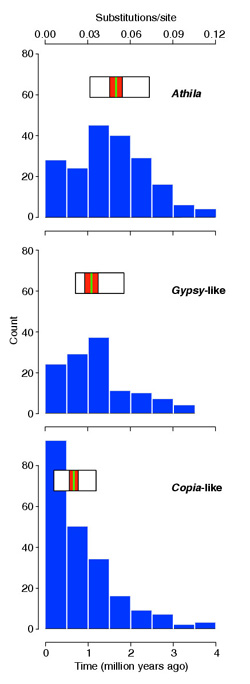
Age distributions of LTR-retrotransposon superfamilies. Athila insertions are on average significantly older, and Copia-like ones younger, than those from other superfamilies. There are 34 Copia-like, four Athila, and three Gypsy-like insertions with identical intra-element LTRs. The width of the horizontal boxes above the histograms indicates the middle 50% of age values in each superfamily; the red band indicates 95% confidence limits on the median, and the green stripe the median value.